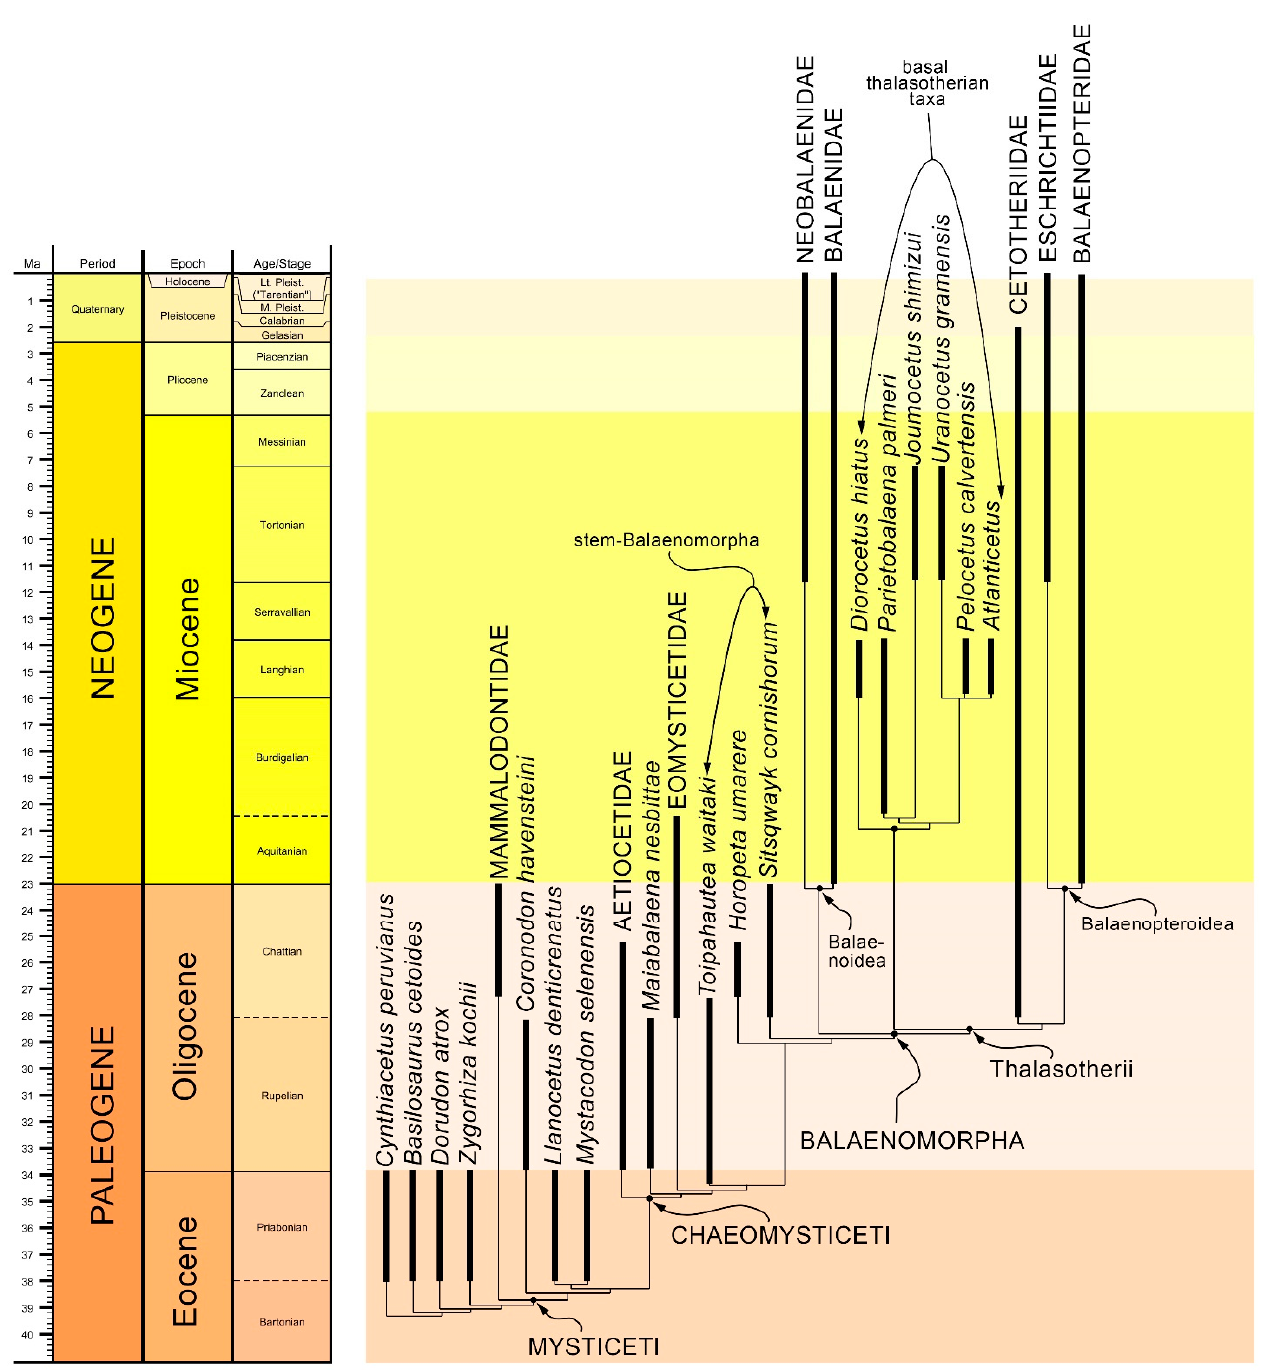
Figure 7. Stratigraphic distributions of the mysticete clades discussed in this paper. The geologic scale chart was produced with TSCreator (https://engineering.purdue.edu/Stratigraphy/tscreator, accessed on 17 July 2020).